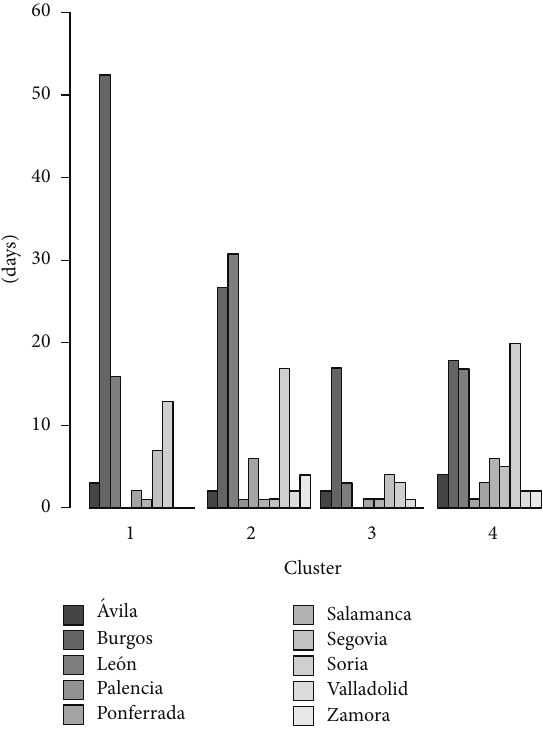
Figure 3: Cluster distribution of snow events by city between 1960 and